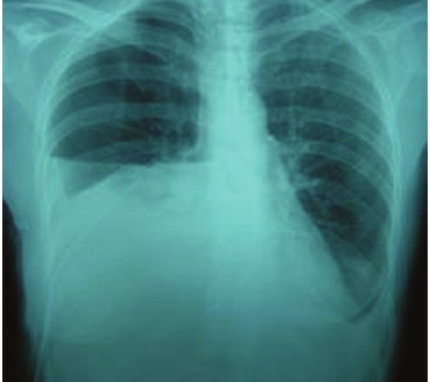
Figure 1: Case 1: chest radiograph showing pleural e ff usion on the right side.